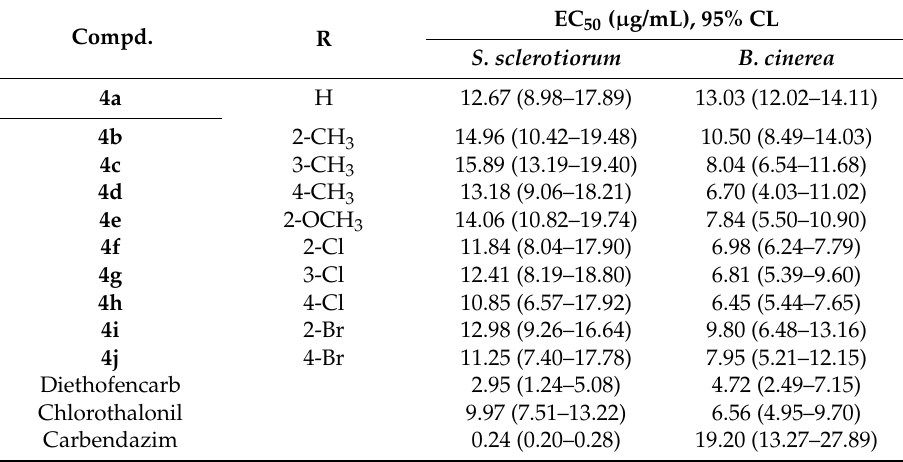
Table 1. Antifungal activities of compounds 4a – 4j (EC 50 ).